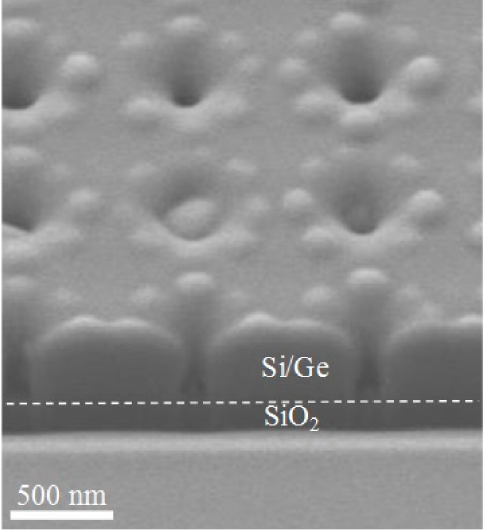
Figure 6. SEM image of a structure cross-section for pit period of 0.8 µ m. The dotted line is drawn for clarity and separates the region of the buried SiO 2 layer and the top Si+epitaxially grown